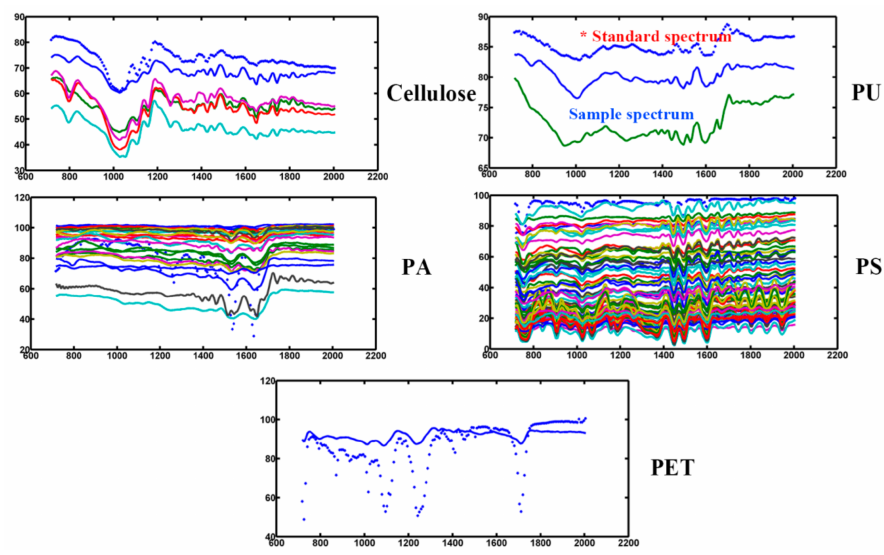
Figure 7. FTIR spectra of typical selected microplastic particle samples in the region of 700–2000 cm − 1 .